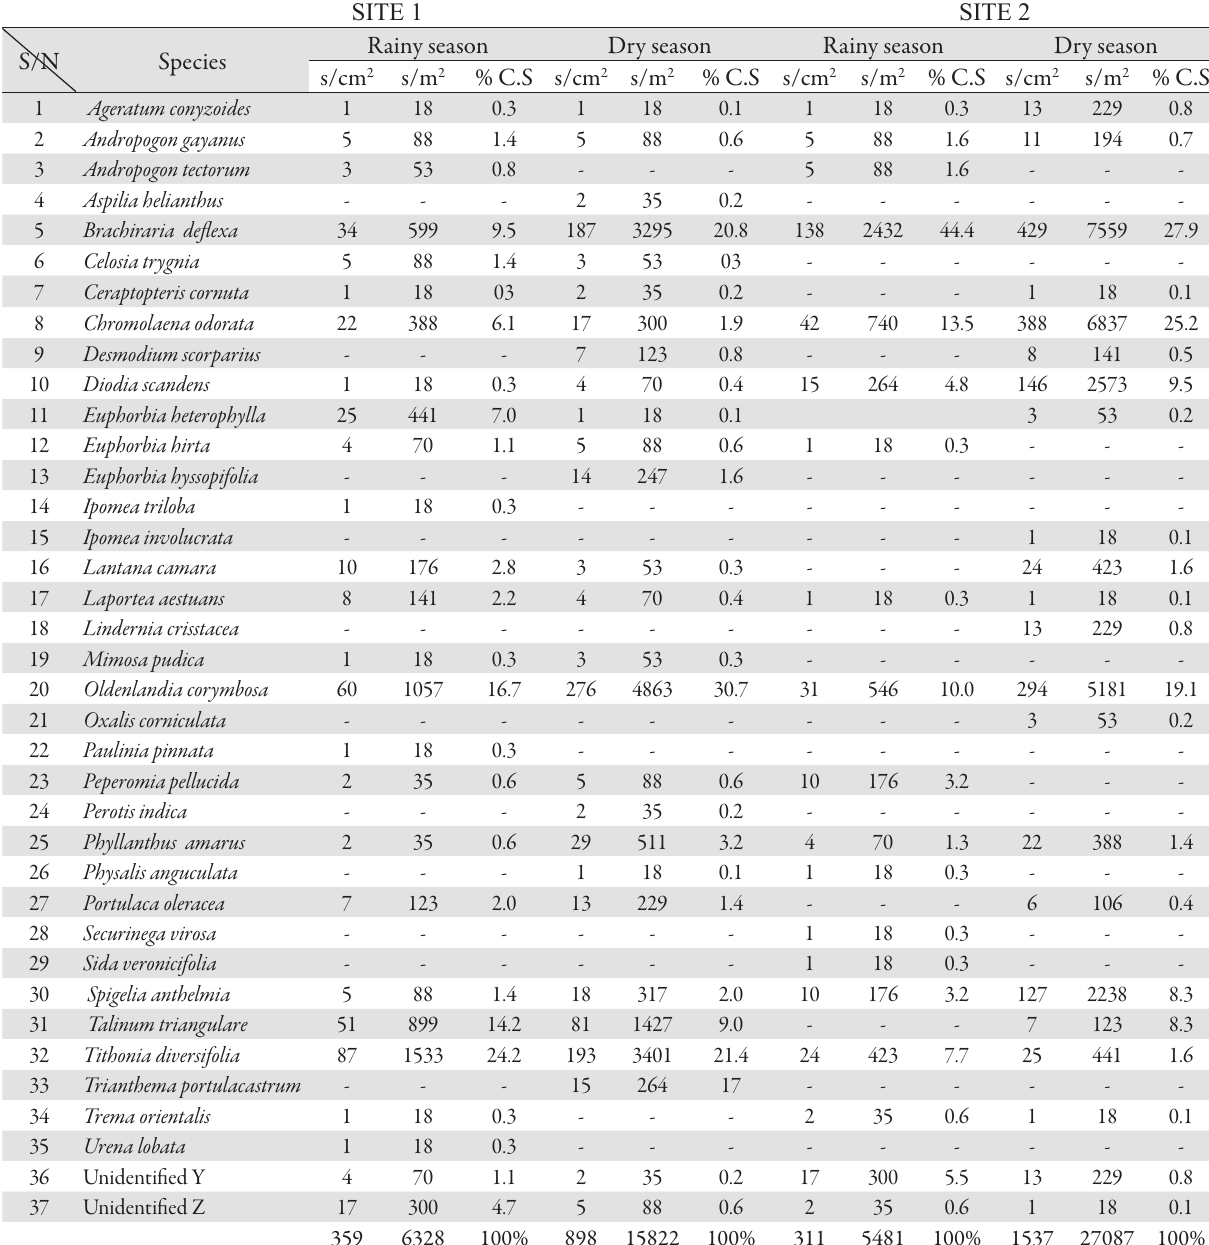
Tab. 2. Density of species (seedlings/cm 2 and seeds/m 2 ) that emerged from soil collection in the two study plots in both seasons (Rainy and Dry